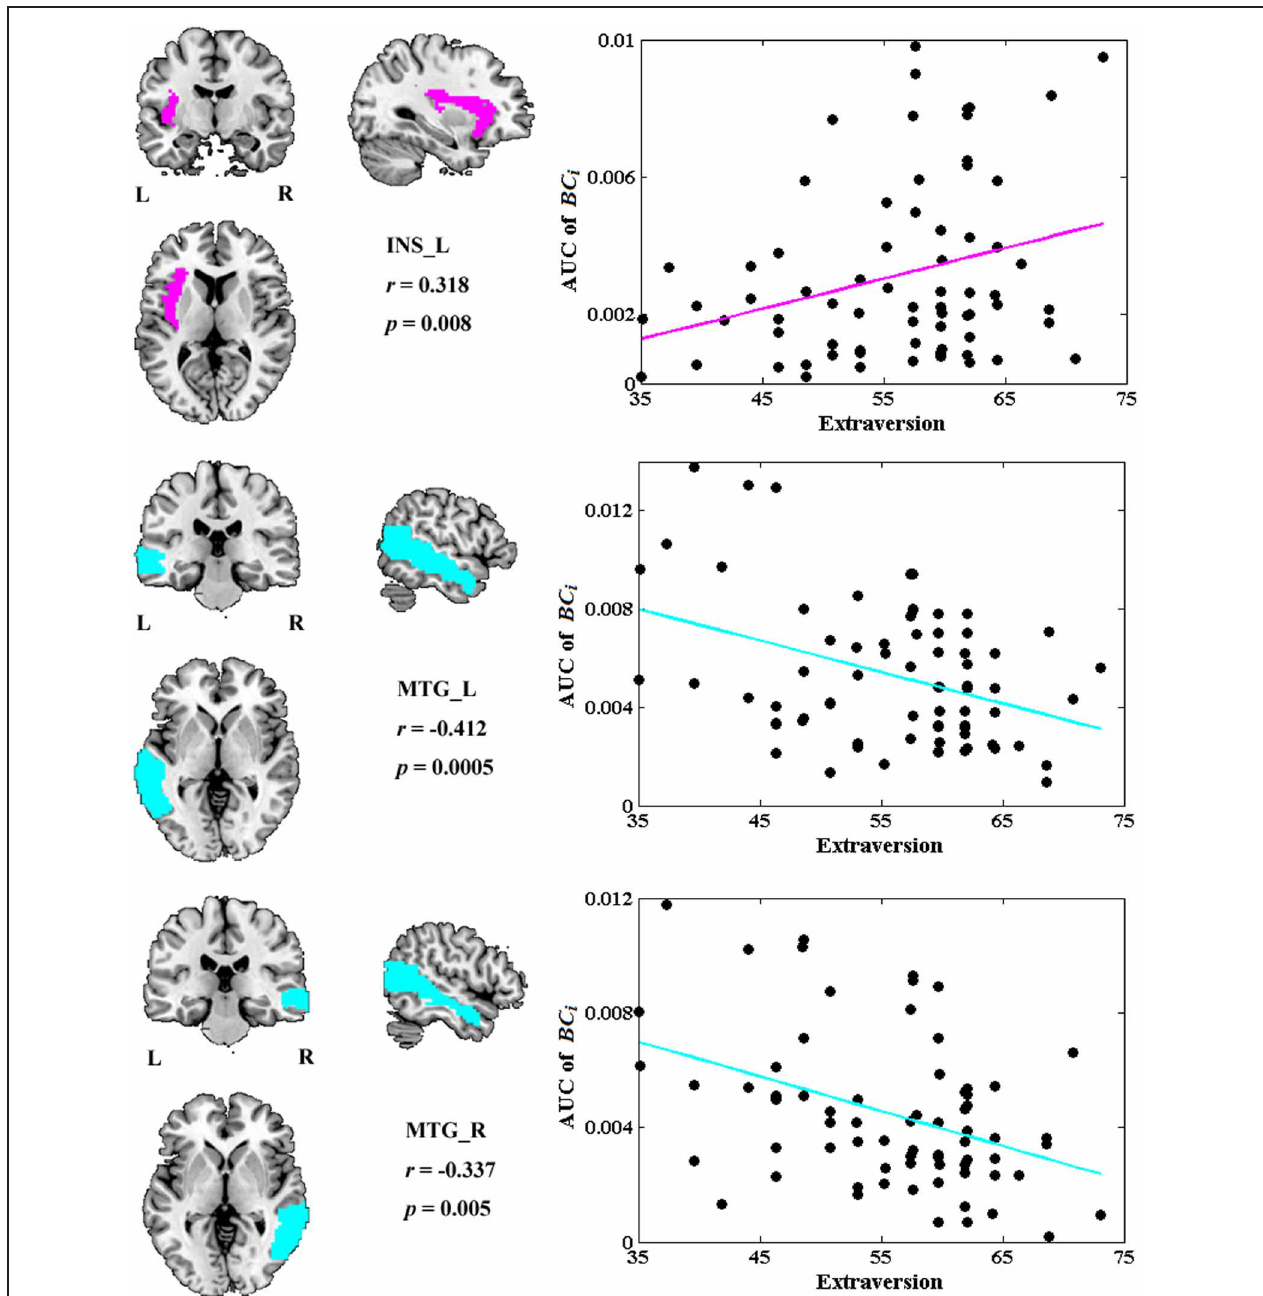
represents the negative correlations, while the magenta color represents the positive correlations. INS, insular; L, left; MTG, middle temporal gyrus; R,